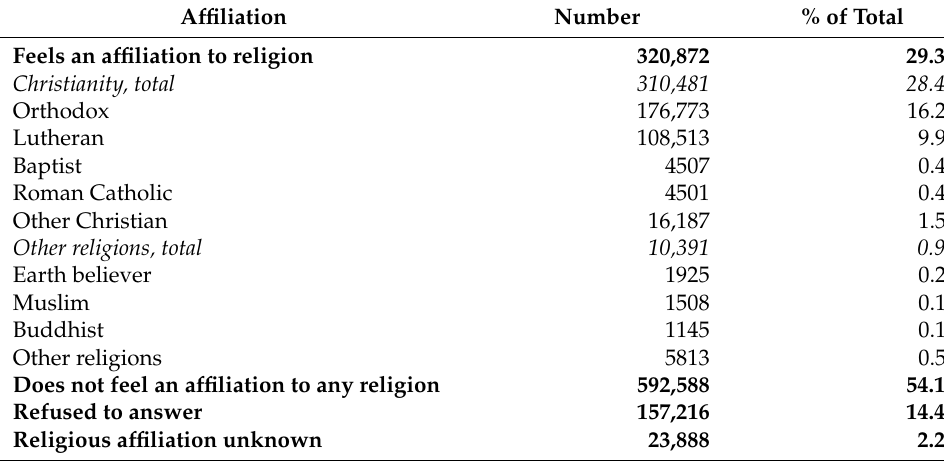
Table 1. Responses to “ Do you have any religious affiliation ?” and “ Please indicate your religious affiliation ”. Source: Statistics Estonia